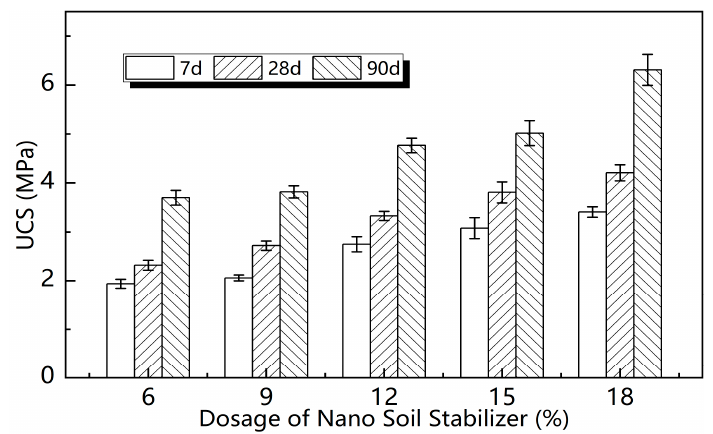
Figure 3. The UCS of nano - stabilized soil by different nano dosages.